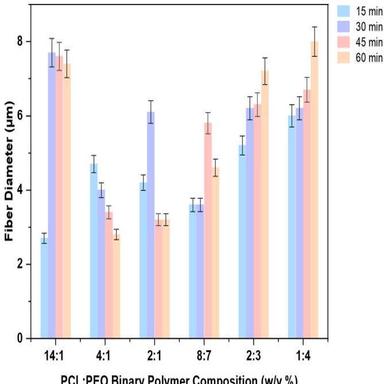
Influence of increasing PEO ratio and swelling behavior on average fiber diameter using PCL:PEO binary polymer system at 14:1–1:4, immersed in deionized water for 15–60 min.